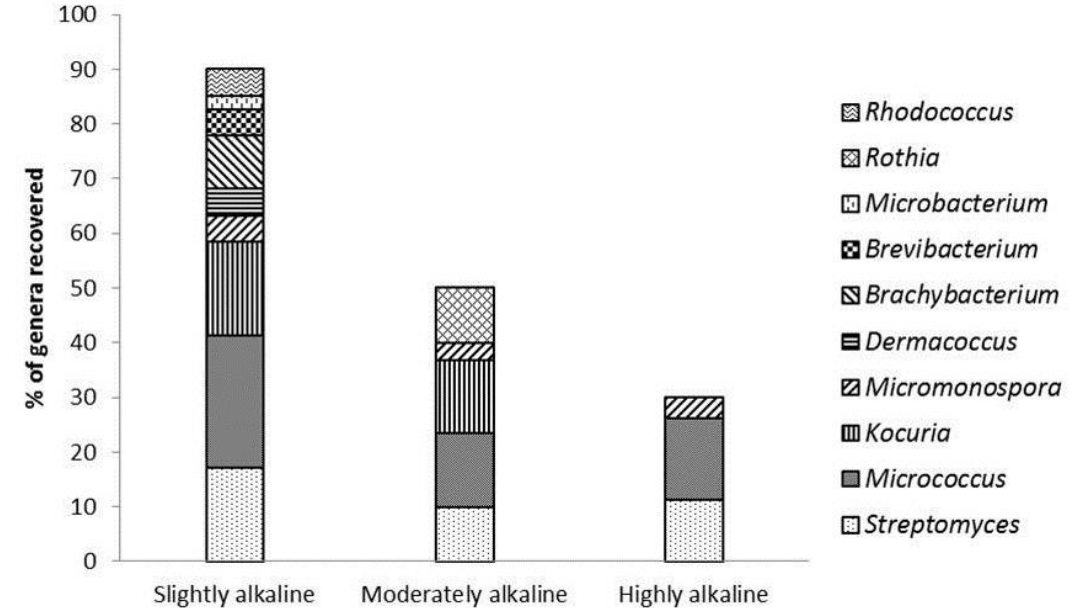
Figure. 2 Percentage of total recovery of genera of Actinobacteria from soils of different alkalinity. Abundance of each genus recovered from different alkalinity was showed in each bar strip Phylogenetic trees were constructed based on 16S rRNA sequences to investigate the evolutionary relationships between the Actinobacteria isolates in this study and their closest taxa members. Streptomyces isolates from Ambato Point, Arturo Prat and Greenwich Island were forming a distinct subclade with the type strains of Streptomyces somaliensis and Streptomyces albidoflavus (Figure. 3a), delineated from other Streptomyces species. The Streptomyces isolates from Pevima Lake were forming a cluster that was represented by Streptomyces rutgersensis . Other than that, putative new species of non- Streptomyces were identified in this study. All of the isolates of Micrococcus were found to be closely related to Micrococcus yunnanensis and shared 16S rRNA gene similarity ranging from 99.5-99.93% (Figureure. 3b). Interestingly, three isolates, namely 64A3a, 62SC2a and 76A3b, formed a distinct cluster out of the subclade of M. yunnanensis that comprised of all other isolates of Micrococcus , which could represent new taxa of M. yunnanensis . A putative new species of Micromonospora were identified, namely, isolate 111H2a, by sharing <99% of 16S rRNA gene similarity with Micromonospora eburnea , and formed a phyletic lineage out from the subclade of M. eburnea (Figure 3c). A Rhodococcus isolate with no mycelial growth was closely related to Rhodococcus yunnanensis by sharing 99.13% 16S rRNA gene similarity. However, it formed a phyletic lineage out from the subclade represented by type strain of Rhodococcus yunnanensis in the phylogenetic tree (Figure 3d), representing a putative new taxon. By sharing 99.78-99.79%, 99.71-99.93% and 100% 16S rRNA gene similarities, the isolates were clustered within the subclades represented by Kocuria marina , Kocuria palustris and Kocuria rhizophila respectively (Figure 3e). The isolates of the genera Brachybacterium , Dermacoccus , Brevibacterium , Microbacterium and Rothia were clustered together with their closest relatives (Figure 3f, 3g, 3h, 3i and